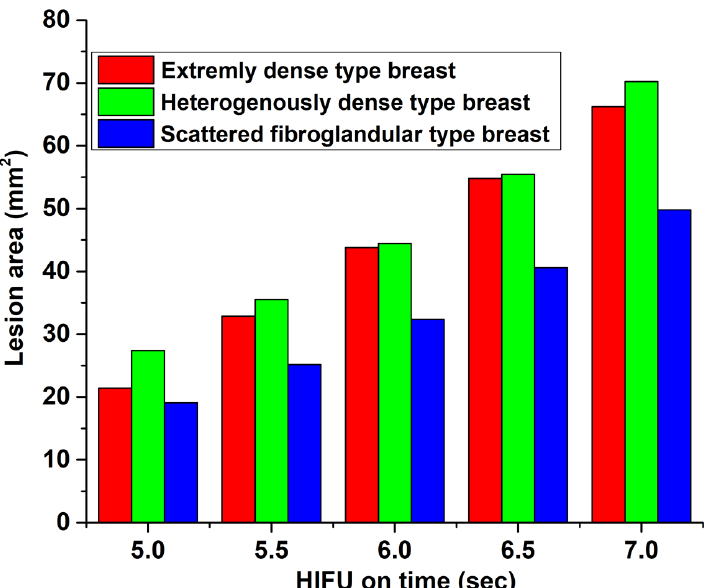
Figure 7. Variation of lesion area (area with CEM 43 > 240) with HIFU